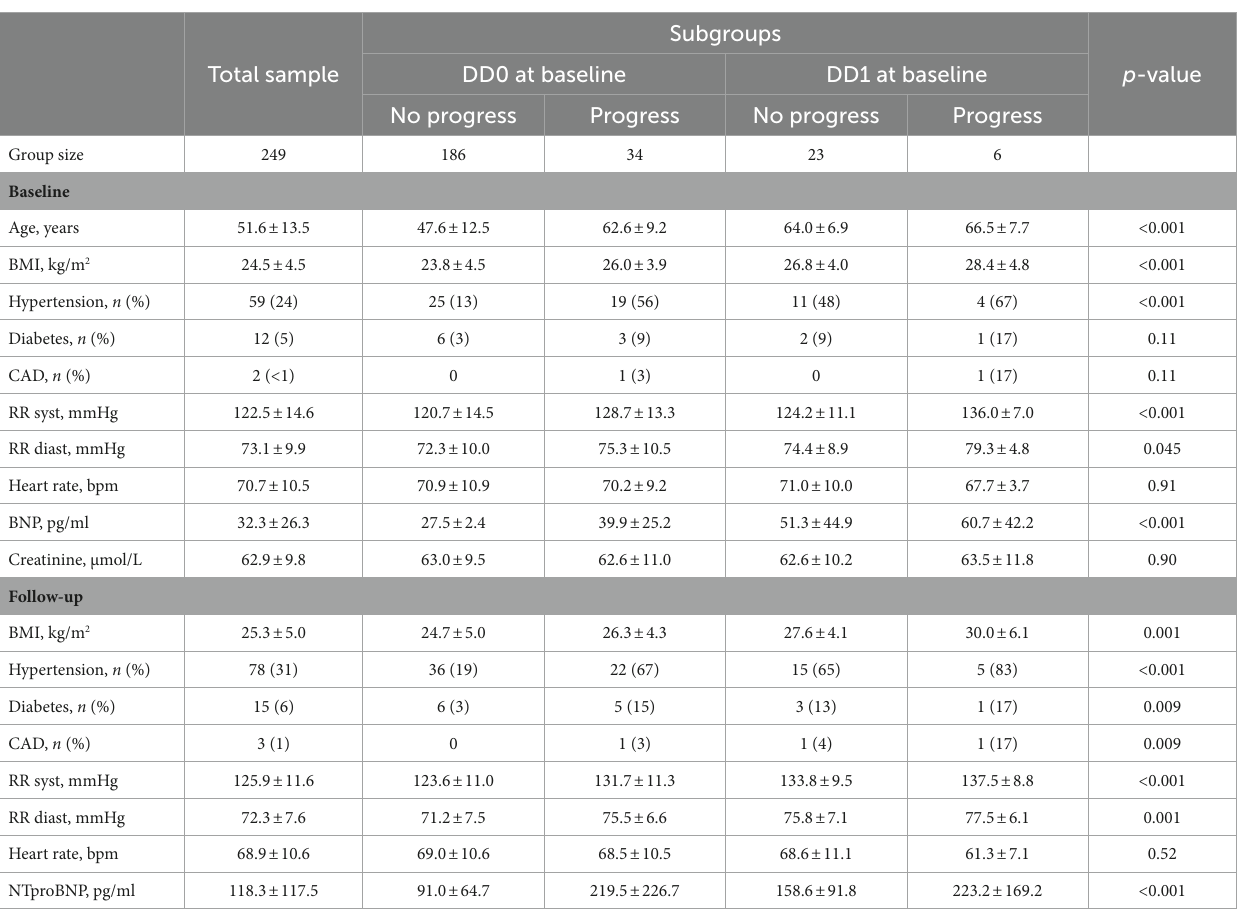
TABLE 1 Demographic and clinical